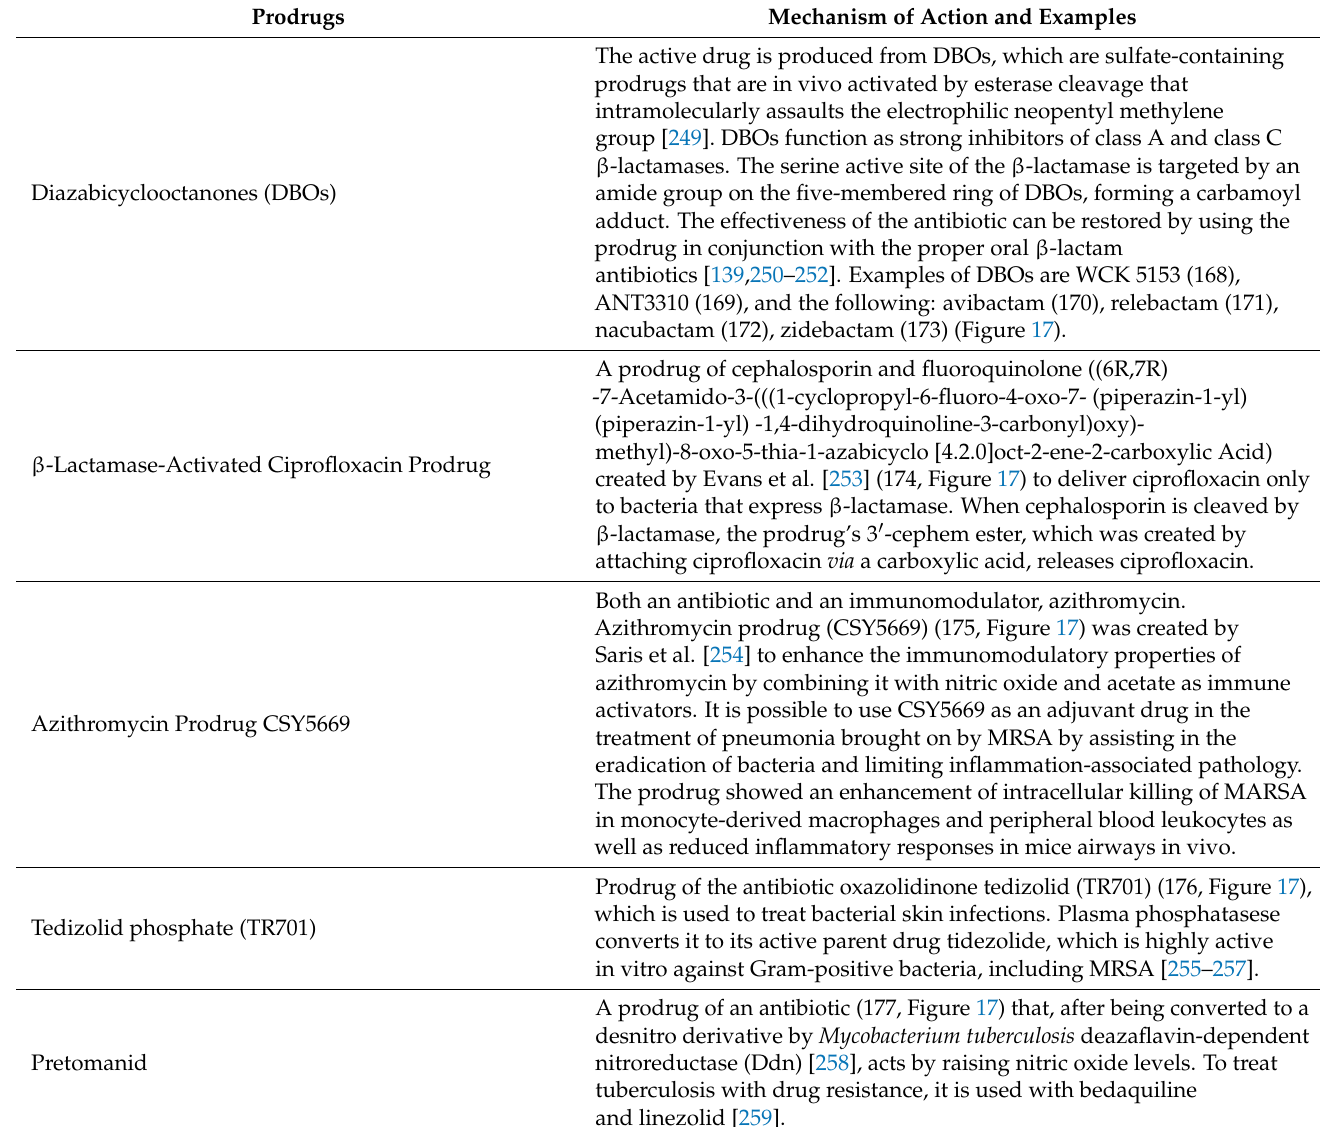
Table 2. Prodrugs and their mechanism of